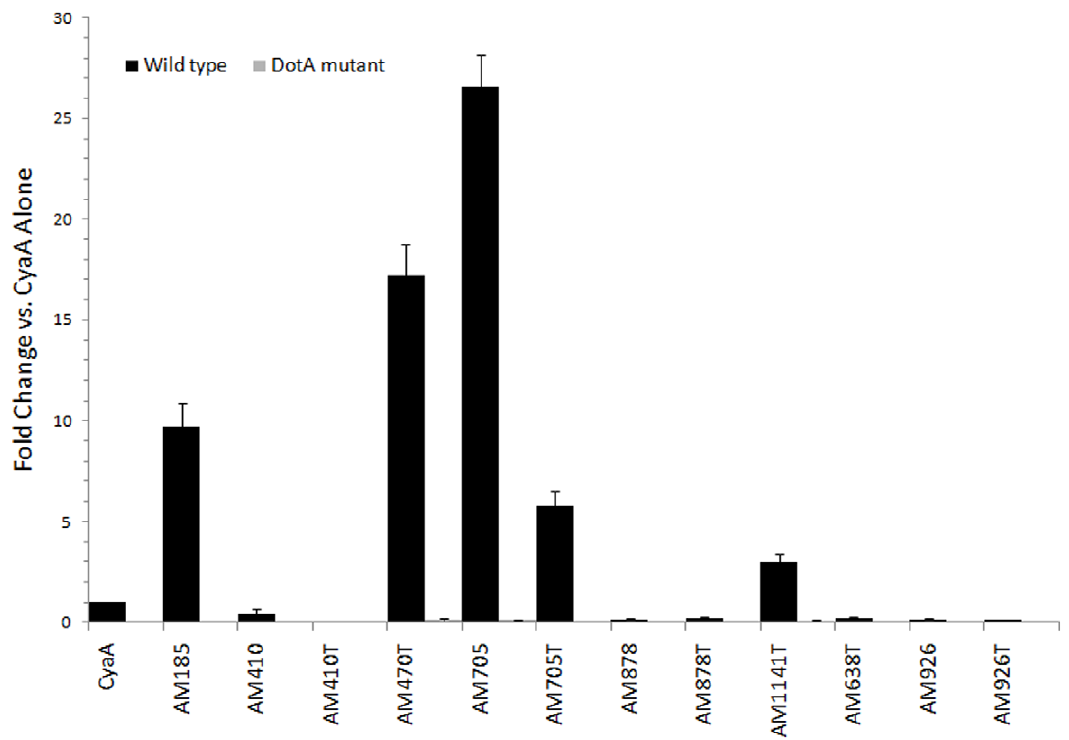
Figure 2. CyaA translocation assays. Intracellular cAMP levels were determined following infection of THP-1 cells with L. pneumophila expressing CyaA fused to individual A. marginale proteins. Results are expressed as fold change over cAMP levels resulting from infection with L. pneumophila expressing CyaA alone (negative control). Increased cAMP levels were observed when AM185, AM470T, AM705 ( ankA ), AM705T, and AM1141T fusion proteins were expressed in wild-type L. pneumophila , and levels similar to the negative-control were observed following expression of all proteins in DotA-deficient L. pneumophila , indicating that secretion requires a functional Dot/Icm T4SS. Results are shown for one experiment performed in triplicate and are representative of at least 2 individual experiments. Error bars represent the standard deviation from the mean. p values are , 0.0001 using a Student’s t-test when comparing secreted AM proteins to CyaA alone or to the DotA mutant cAMP levels.